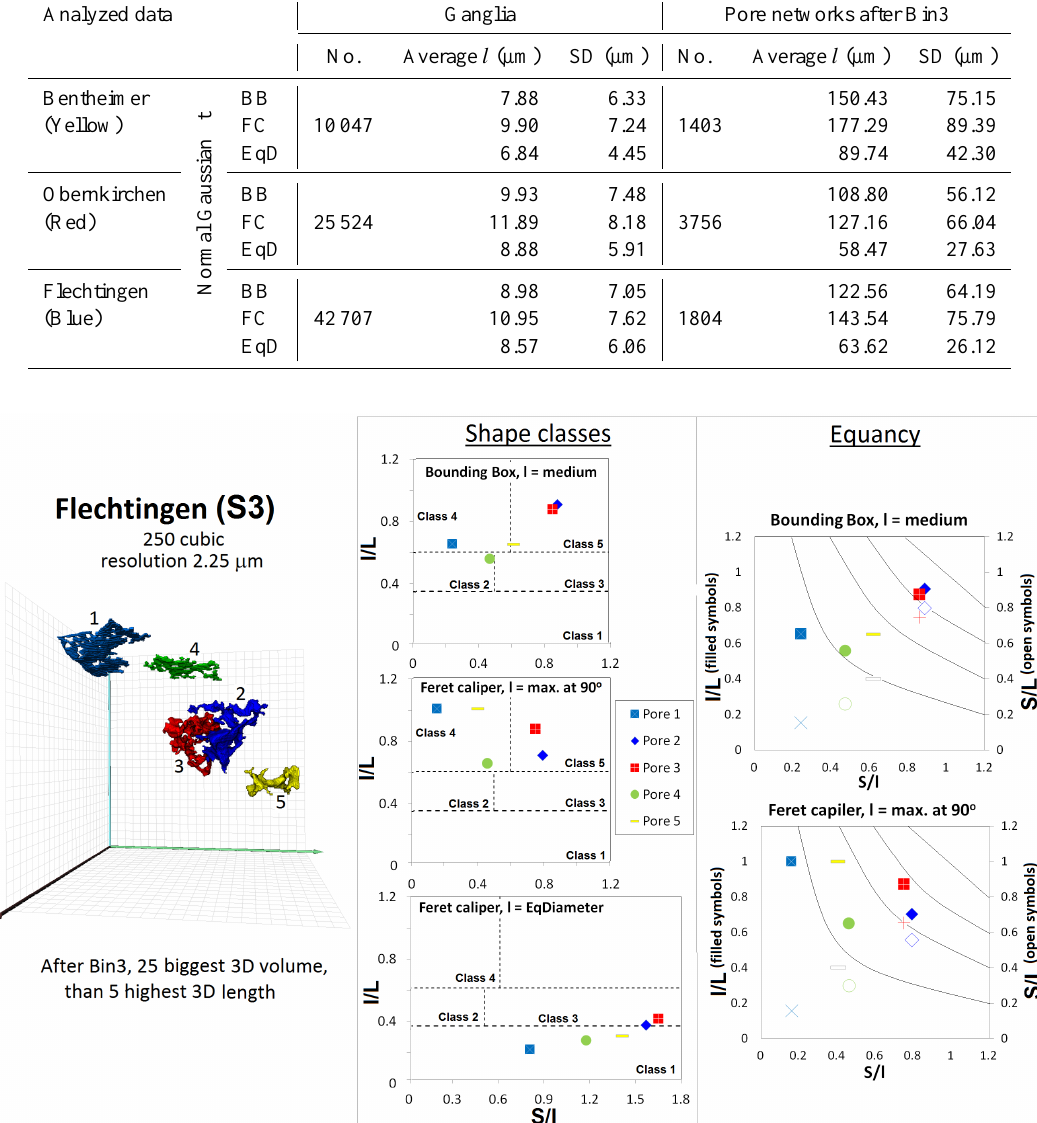
Figure 9. Pore shape results (S 3 ) of equancy and shape classes based on distinct descriptors for the five categorized pores in a 250 3 voxel volume. The lines shown in the graphics delimitate distinct particles shapes, as described in Fig.